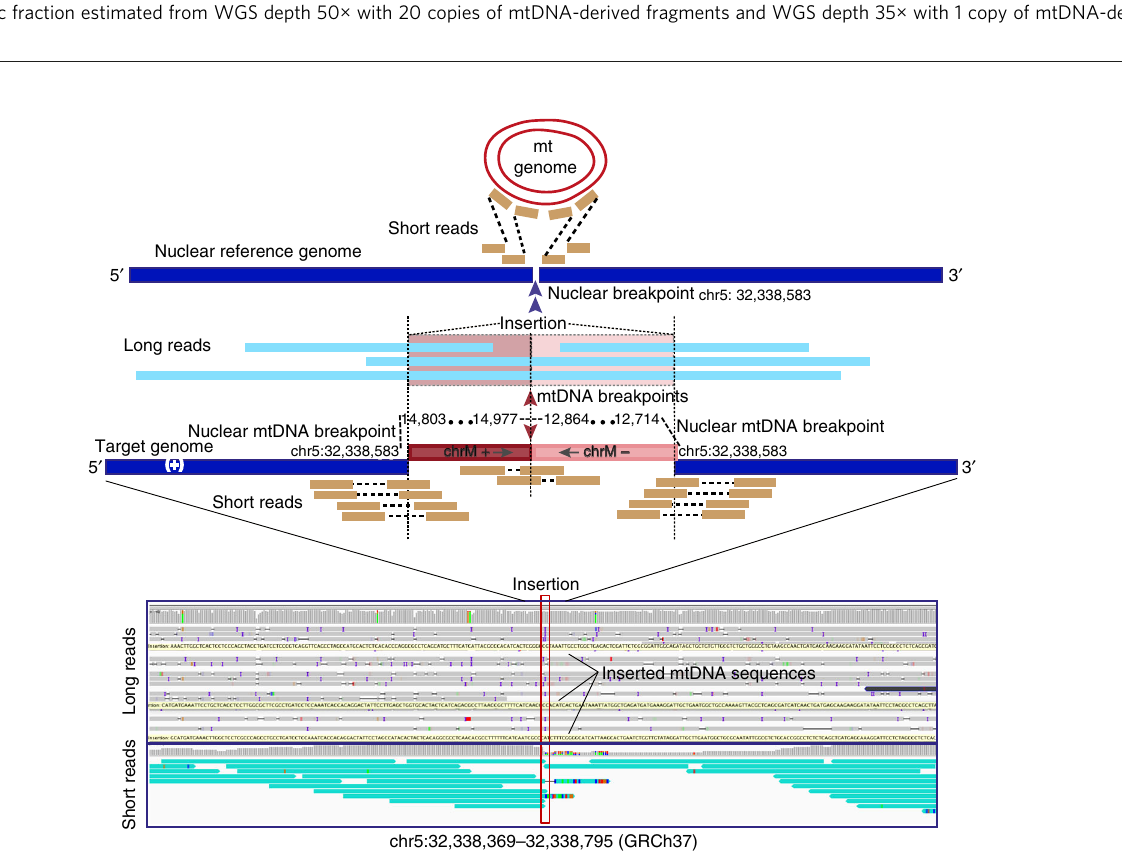
Fig. 6 Validation of NUMTs using long-read (Oxford Nanopore PromethION) sequencing. Example shown is a concatenated mtDNA NUMT detected by both long-read sequencing and short-read sequencing. mtDNA and nuclear genome reference sequences are shown on the top in red and navy. Aligned short reads shown in orange and long reads in light blue. The sequenced genome included concatenated mtDNA sequences (fragment 1: mt 14803-14977 ( + ) and fragment 2: 12864-12714 ( − )) inserted into chr5: 32,338,583. The two mtDNA fragments are coloured in red and plink. The sequences of the long reads aligned to two mtDNA fragments are also highlighted in red and pink. The remaining sequences aligned to nuclear genome in the same region. The IGV screenshot shows both long-read (top) and short-read (bottom) alignments. The insertion point on the nuclear genome is highlighted by the red box. The yellow bars on the long-read alignment are the large insertions from mtDNA sequences. Teal bars on the short-reads alignment are the discordant reads which one read aligned to nuclear genome and their mate reads aligned to mtDNA